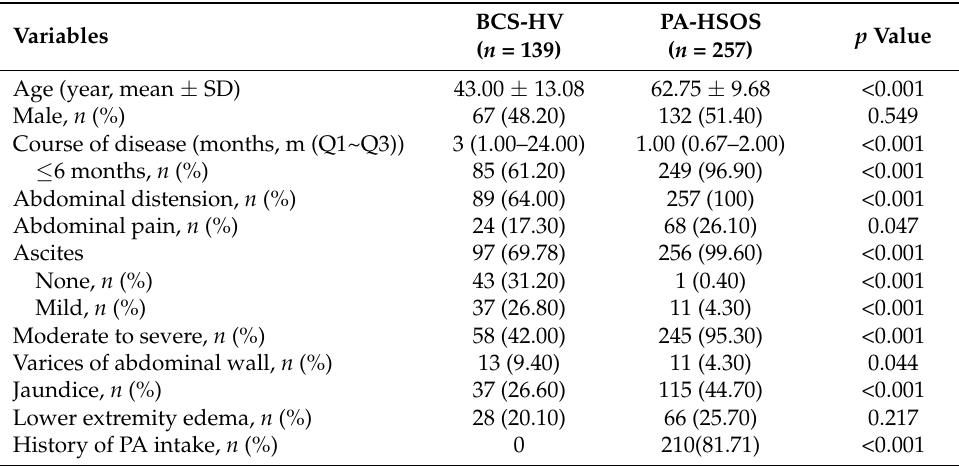
Figure 1. Flowchart of the enrollment of patients with BCS-HV or PA-HSOS. Table 1. The epidemiology and clinical manifestations of the patients.